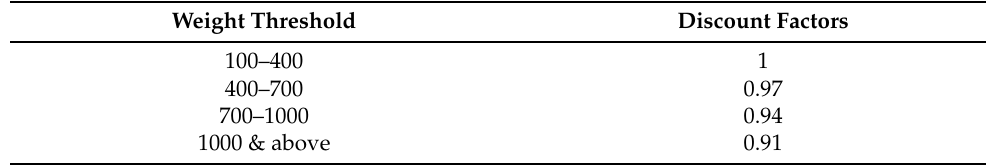
Table A10. Weight threshold and discount factors for all periods